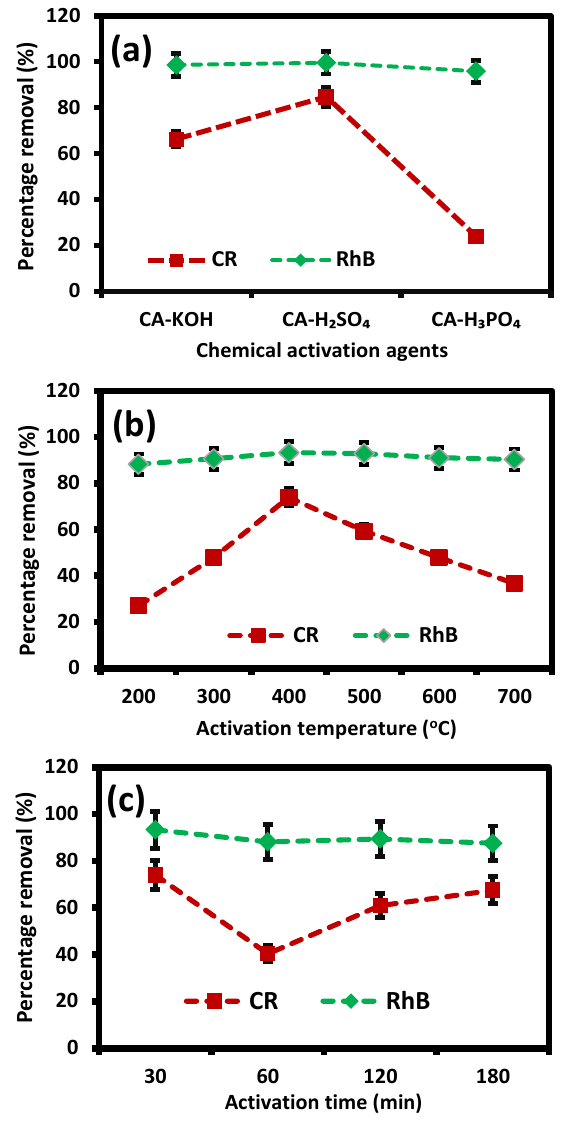
Figure 6. The removal percentage of CR and RhB dyes on the synthesized PTFAC with different ( a ) chemical activation reagents, ( b ) activation temperature of CA-PTF-H 3 PO 4 , and ( c ) activation times of CA-PTF-H 3 PO 4 at 400 °C.